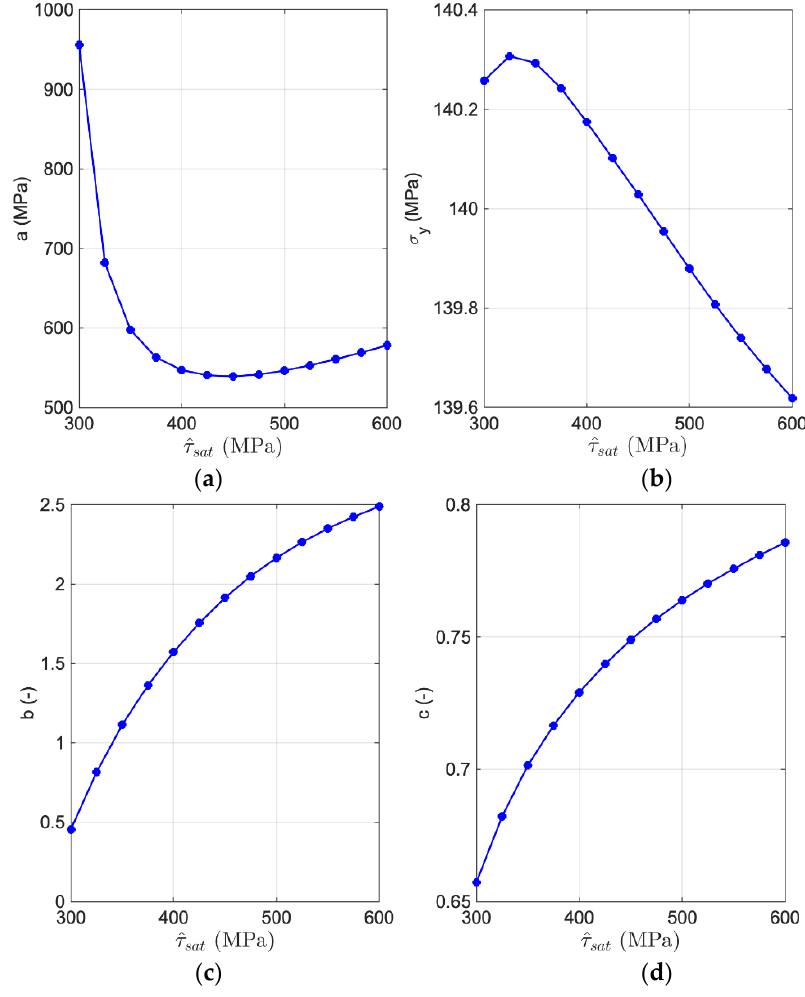
Figure 6. Variation of hardening parameters with change in τ (cid:3548) sat , ( a ) a , ( b ) σ y , ( c ) b and ( d ) c .